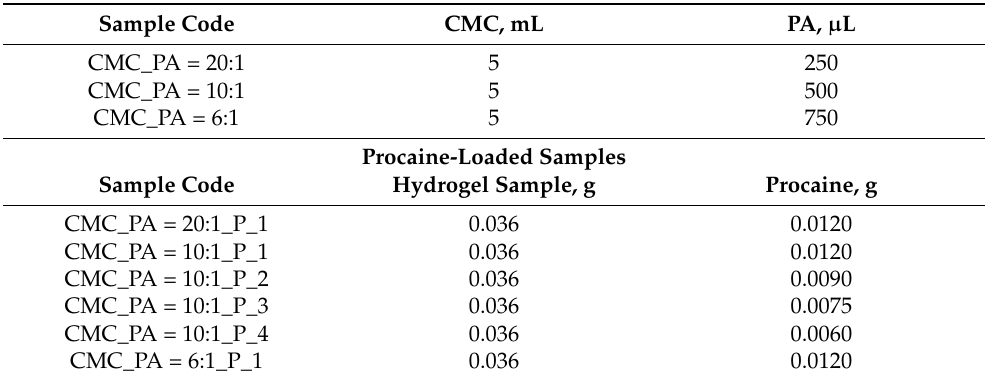
Table 5. Chemical composition of the CMC hydrogels in relation with the PA crosslinker